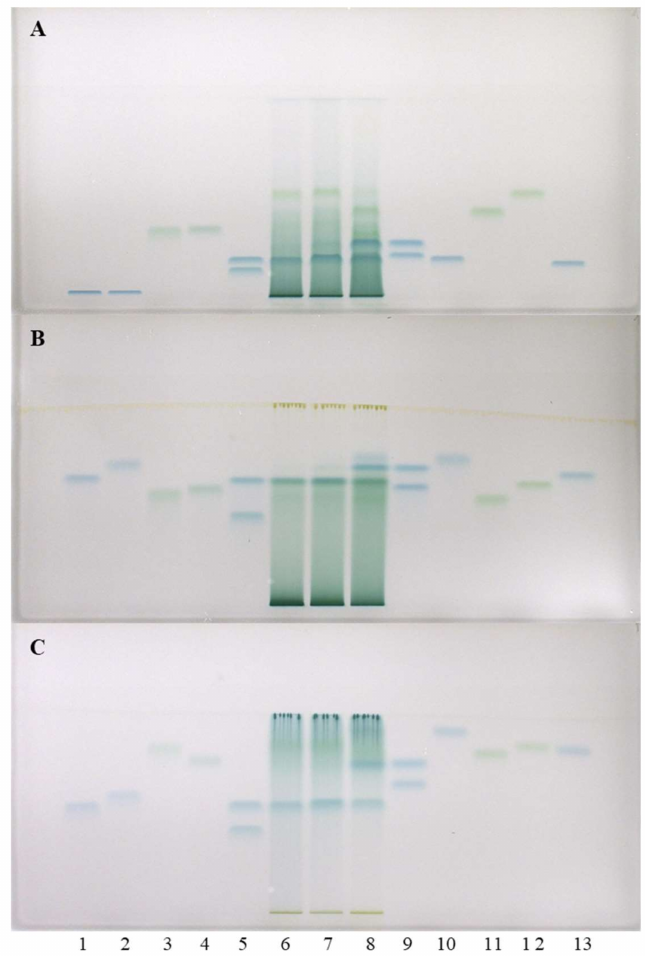
Figure 3. HPTLC chromatograms for the qualitative determination of flavan-3-ols and proanthocyanidins in STSs from leaves (1 µ L, 50 mg / mL) of Japanese (track 6), Bohemian (track 7) and giant (track 8) knotweed based on standards of ( − )-gallocatechin gallate (60 ng; track 1), ( − )-catechin gallate (60 ng; track 2), procyanidin C1 (150 ng; track 3), procyanidin B3 (100 ng; track 4), ( − )-epicatechin (50 ng; track 5, higher R F ), ( − )-epigallocatechin (60 ng; track 5, lower R F ), ( + )-catechin (50 ng; track 9, higher R F ), ( − )-gallocatechin (60 ng; track 9, lower R F ), ( − )-epicatechin gallate (60 ng; track 10), procyanidin B1 (120 ng; track 11), procyanidin B2 (90 ng, track 12) ( − )-epigallocatechin gallate (60 ng; track 13). The HPTLC cellulose plates were developed with water ( A ), 1-propanol-water-acetic acid (4:2:1, v / v ) ( B ), 1-propanol-water-acetic acid (20:80:1, v / v ) ( C ) as developing solvents and documented after derivatization with DMACA detection reagent at white light